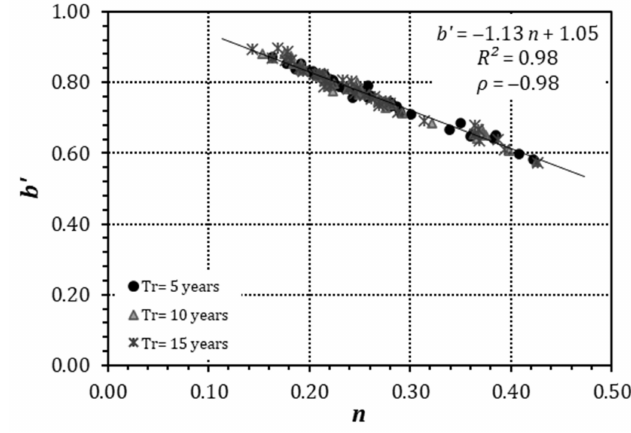
Figure 3. Regressive equation for parameters b (cid:48) (3p-DDF) and n (2p-DDF).